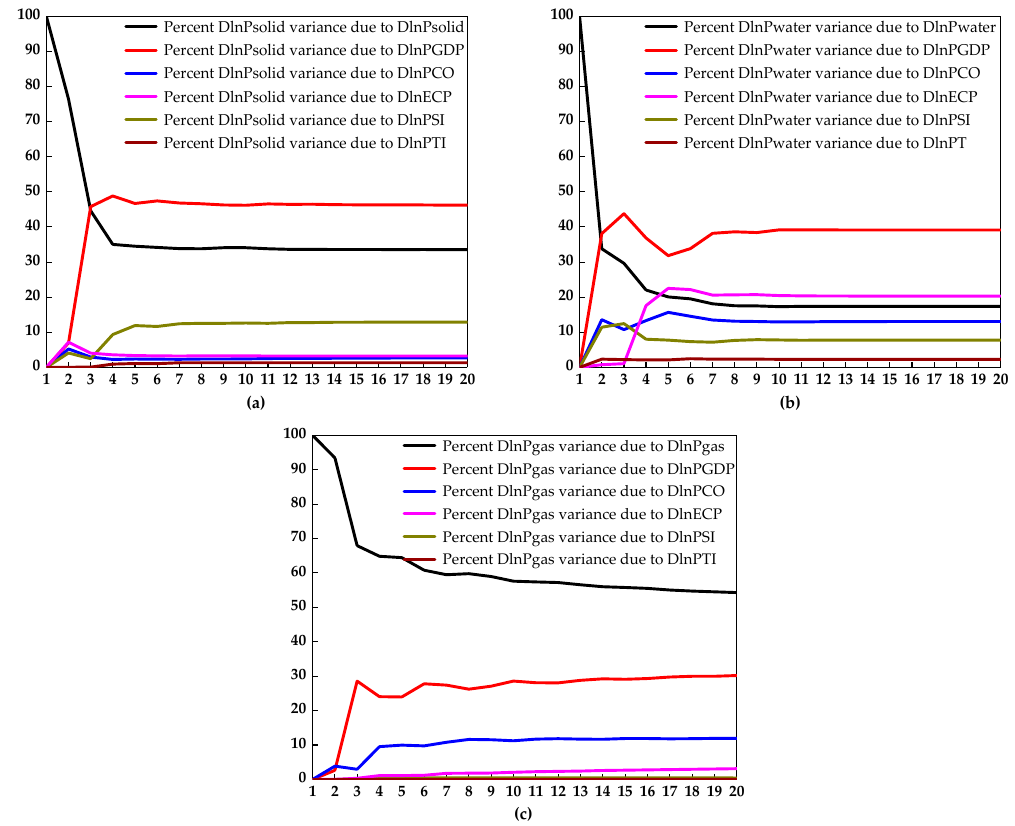
Figure 4. The variance decomposition of industrial “three wastes” emissions. ( a ) The result of variance decomposition of DlnPsolid. ( b ) The result of variance decomposition of DlnPwater. ( c ) The result of variance decomposition of DlnPgas.